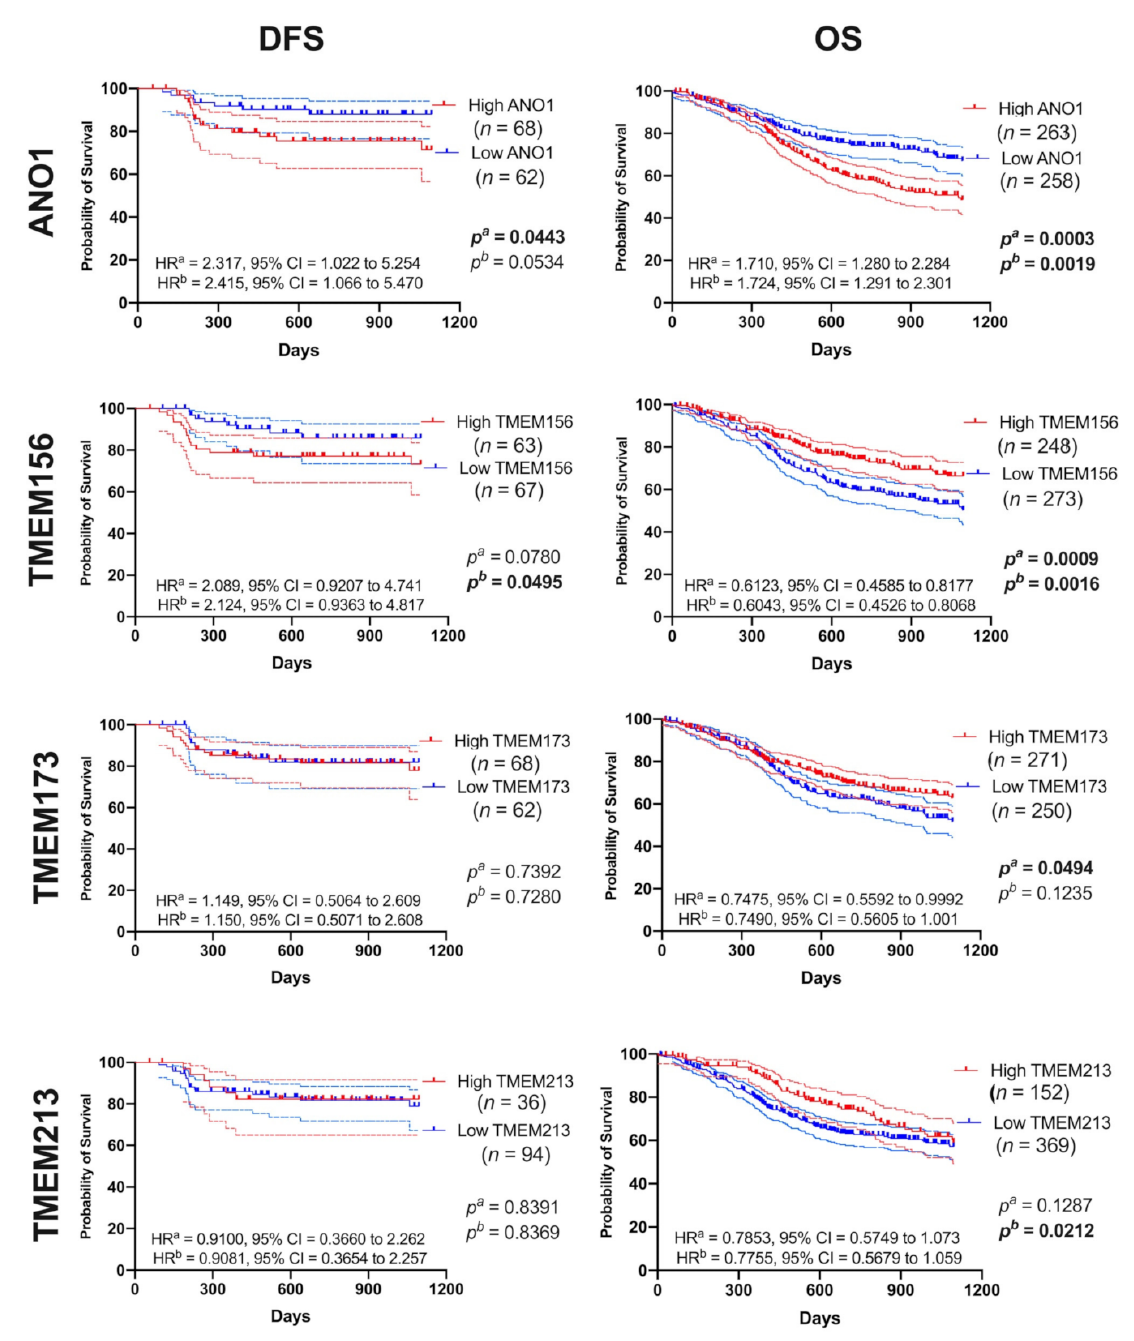
Figure 4. Disease-free survival (DFS) and overall survival (OS) curves (darker lines) with 95% CI (lighter lines) of HNSCC patients depending on ANO1 or TMEM156 or TMEM173 or TMEM213 expression levels; high and low subgroups of patients divided based on the mean of expression level; n —number of cases in each subgroup; p a —log-rank (Mantel–Cox) test, and p b —Gehan-Breslow-Wilcoxon test; HR a —Hazard Ratio-Mantel–Haenszel, HR b —Hazard Ratio-log-rank; CI —confidence interval; p < 0.05 considered as